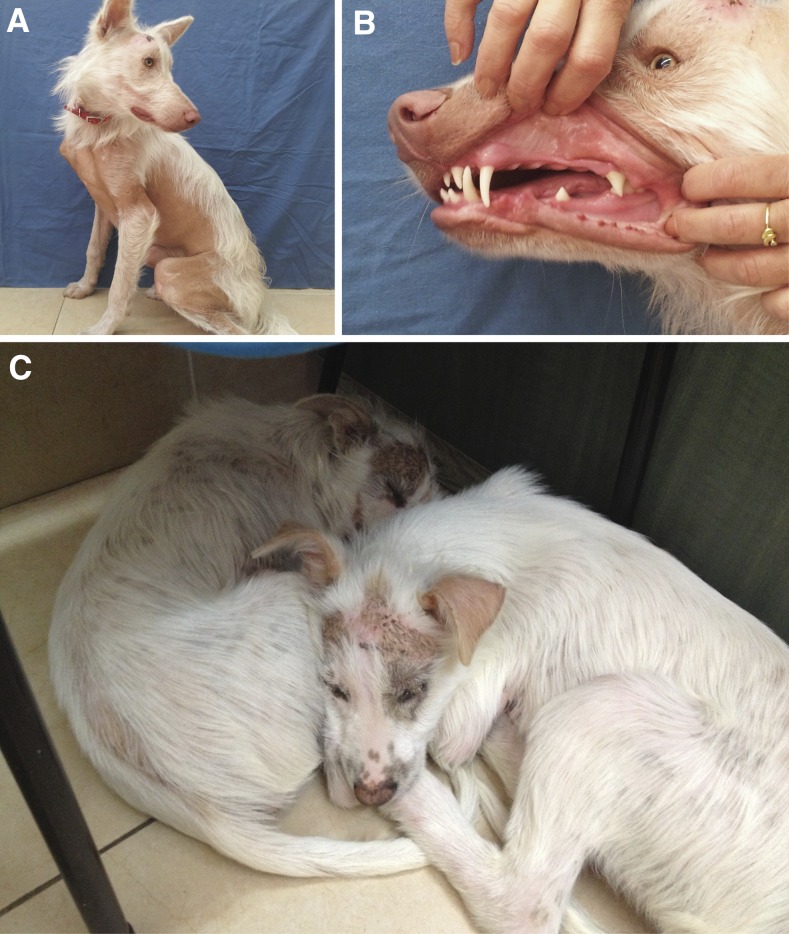
Ectodermal dysplasia phenotype. (A) Pronounced hypotrichosis and alopecia in an affected dog (DS032) at 14 months of age. (B) Dentition abnormalities in the same dog. Note several missing molars in the upper and lower jaw, and the pointed shape of the existing incisors and molars. (C) Two 3-month-old brothers (DS041 and DS042) with unknown familial relationship to the first case also presented with pronounced hypotrichosis, and some completely hairless skin areas.